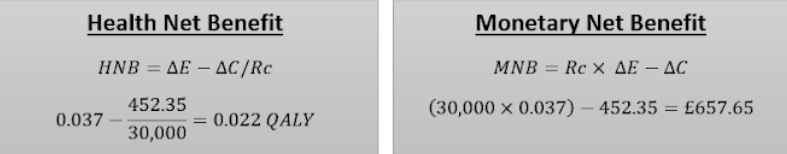
Figure 2. Health and monetary net benefit of